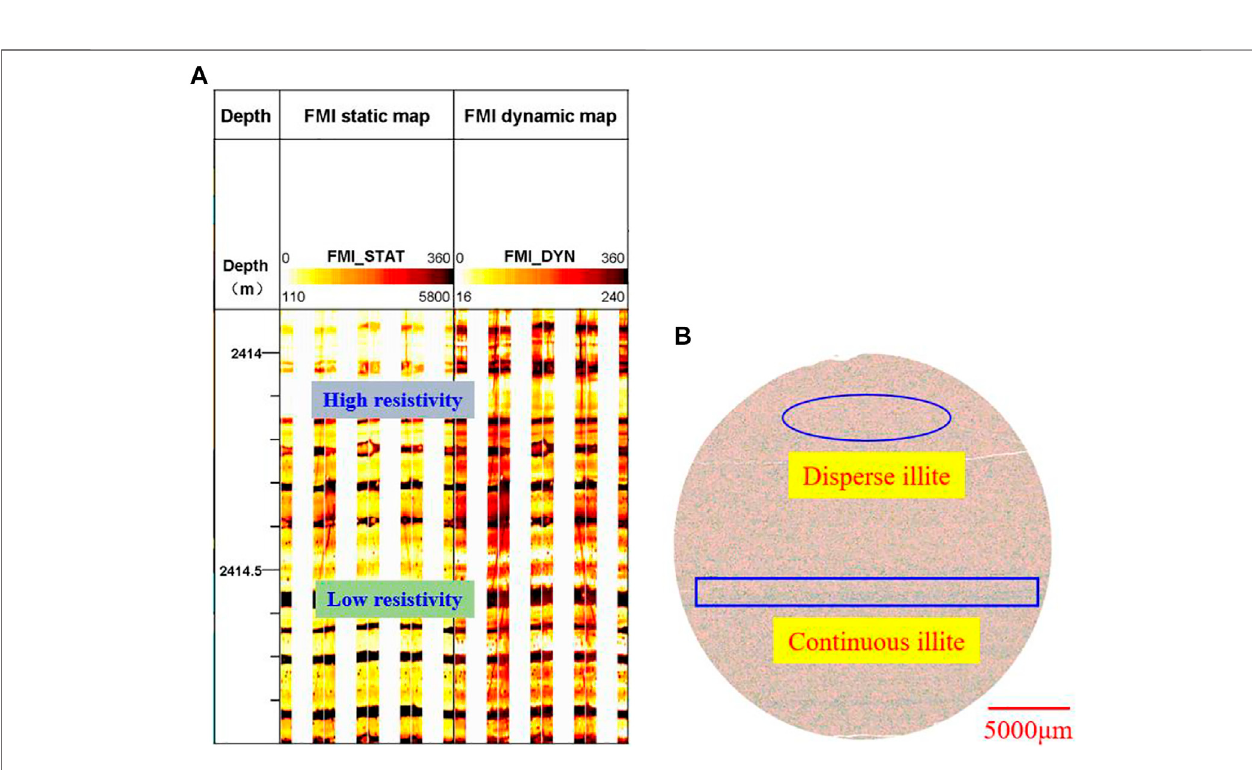
Frontiers in Earth Science |